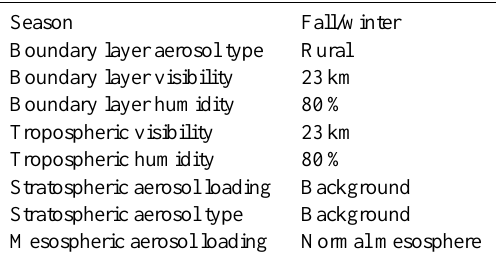
Table 1. Aerosol settings, based on Lowtran (moderate aerosol). Table 2. Trace gases